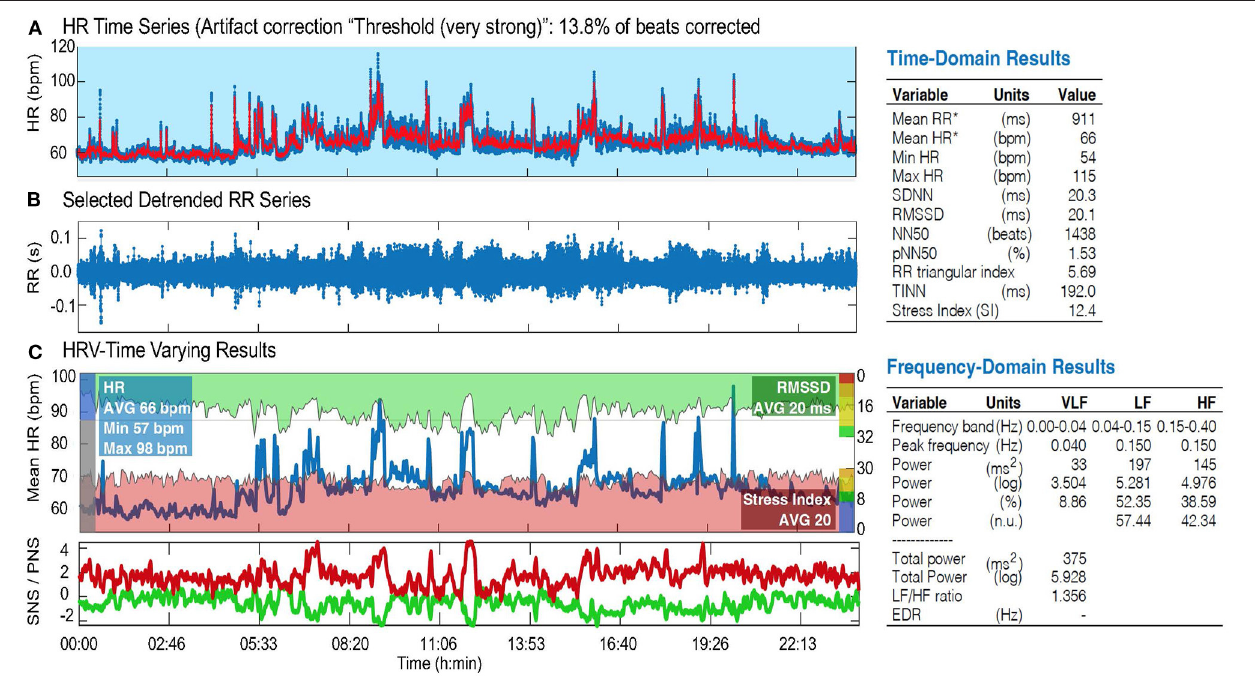
FIGURE 2 | HRV analysis (Kubios) in one ALS patient showing altered sympathovagal imbalance: HRV time series (A) , selected detrended RR series (B) , and HRV-time varying results (C) , including time and frequency-domain results. HR, heart rate; SNS/PNS, sympathetic/parasympathetic nervous system; bpm, beats per minute; RMSSD, root mean square of the successive differences; SDNN, standard deviation of normal to normal R-R intervals; NN50, number of pairs of successive NN (R-R) intervals that differ by more than 50 ms; pNN50, proportion of NN50 divided by the total number of NN (R-R) intervals; TINN, triangular interpolation of NN interval histogram; VLF, very low frequency; LF, low frequency; HF, high frequency band of HRV.